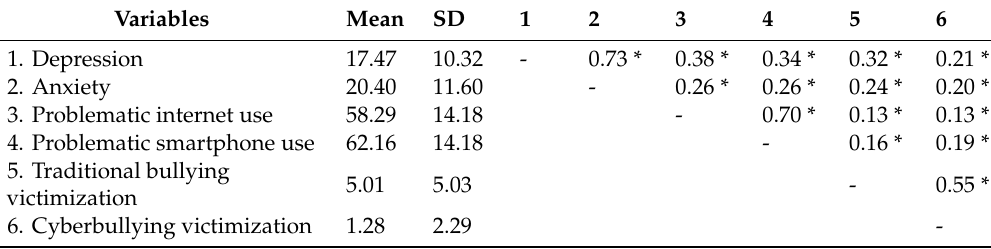
Table 1. The correlation matrix of observation